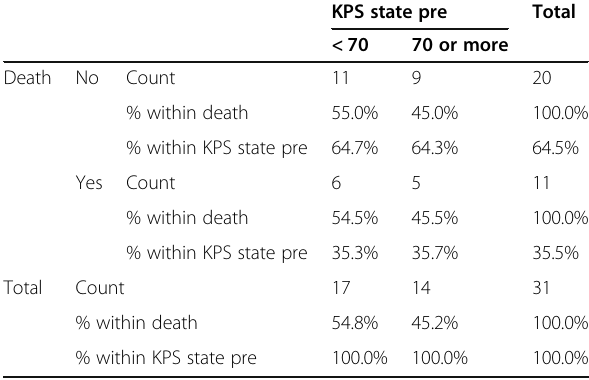
Table 3 The relationship between mortality and KPS state pre